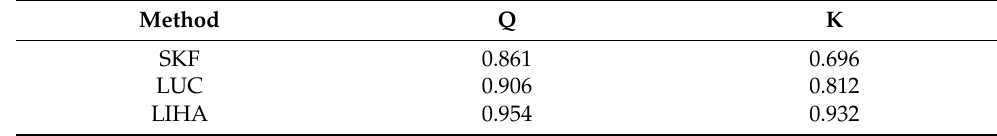
Table 2. Quality index and Cohen’s K coefficient for the three terraces’ identification methods.